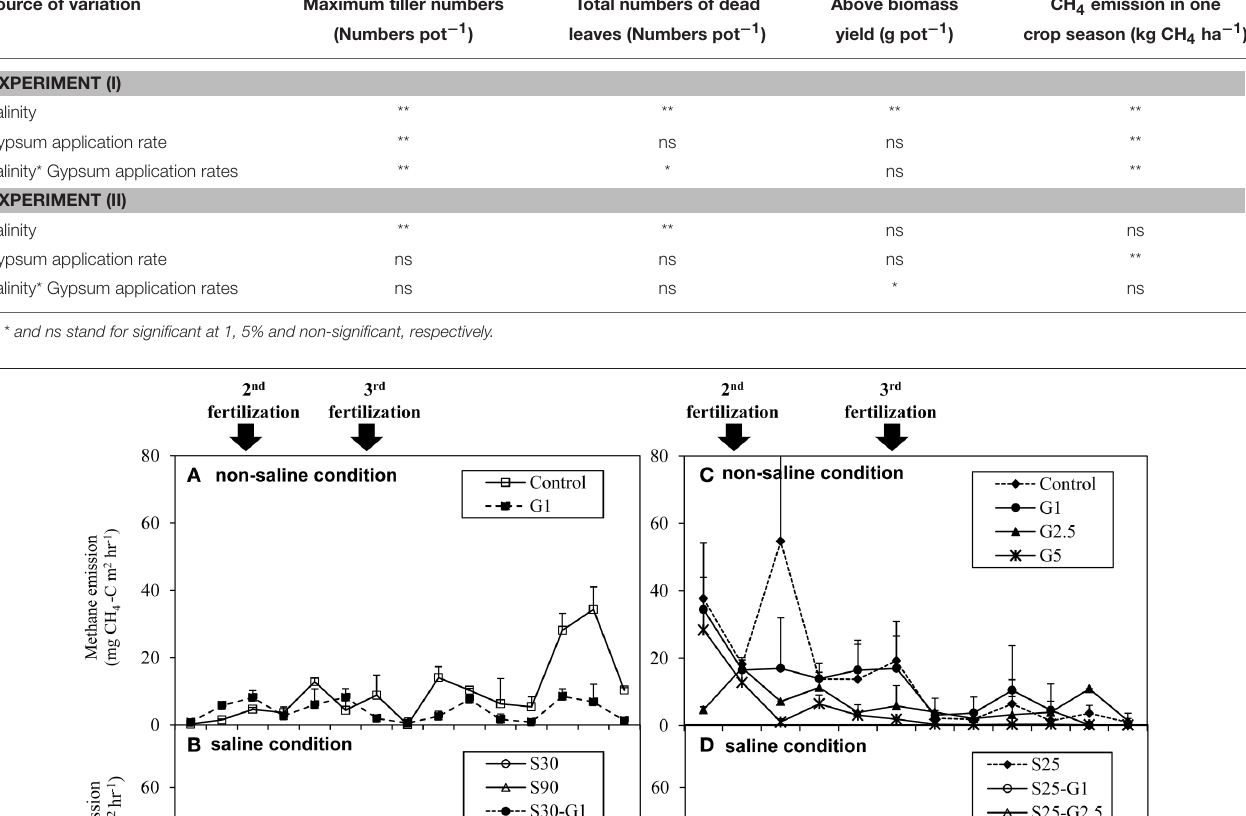
nitrification rate up to 56.8 µ g N g − 1 day − 1 , which was four